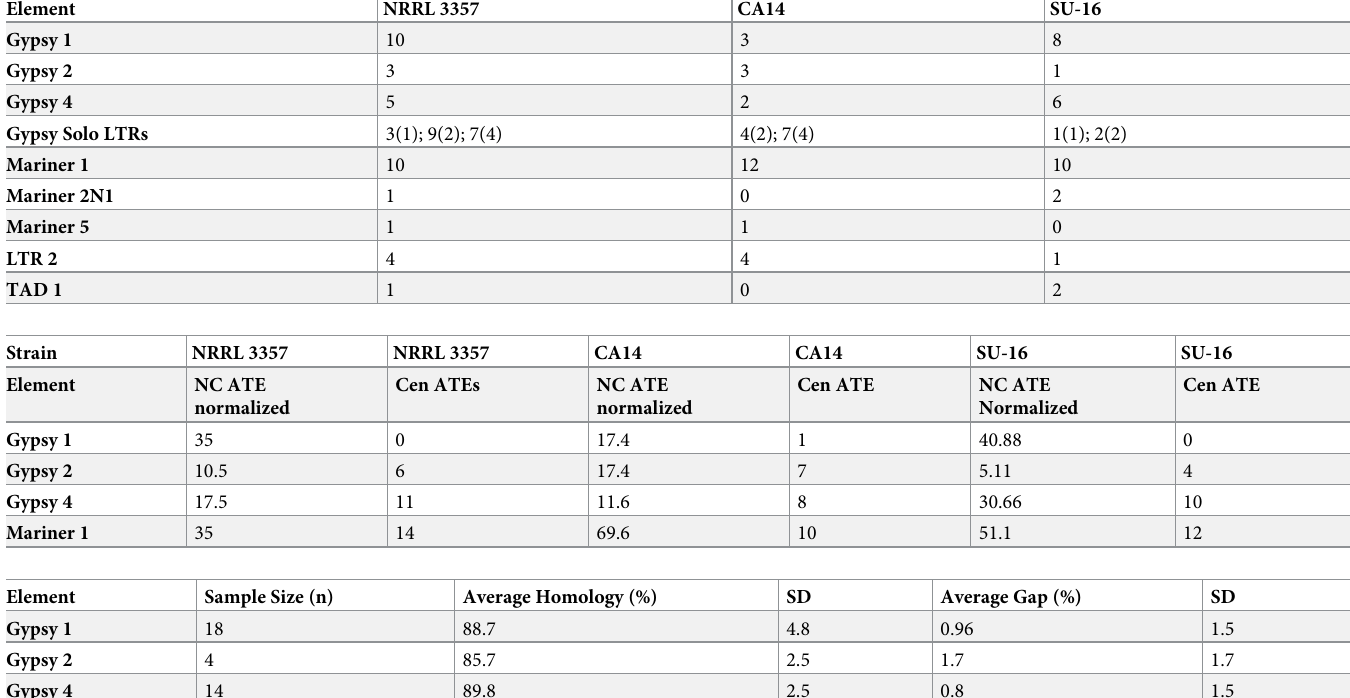
Table 4. Characterization of Gypsy and Mariner TEs in Aspergillus flavus strains. A. Distribution of non-centromeric TE homologs. B. Density of TEs in centromeric and non-centromeric ATEs. C. Homology among Gypsy elements in ATEs.